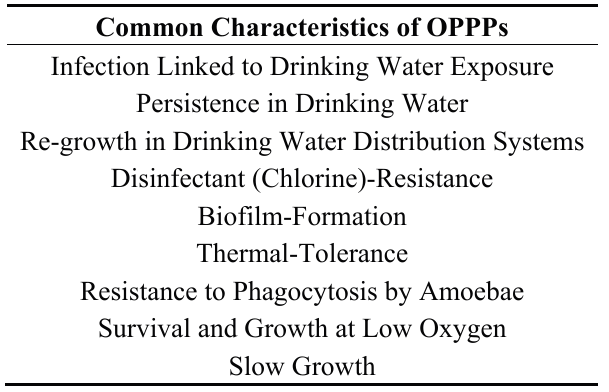
Table 2. Common characteristics of waterborne residential, commercial, and household